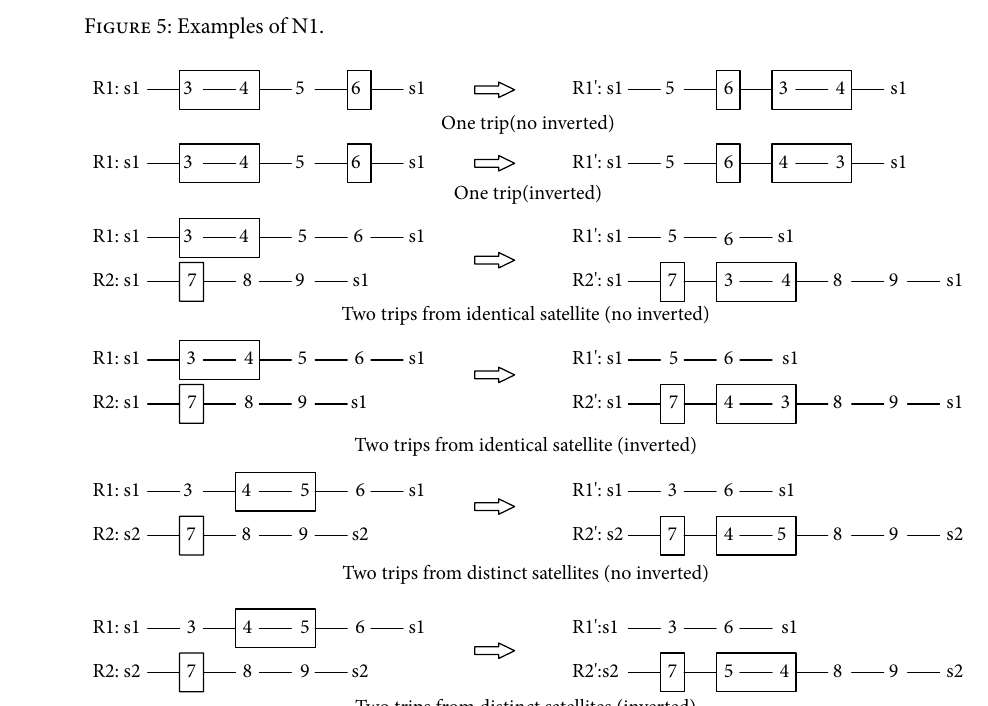
Figure 6: Examples of N2.